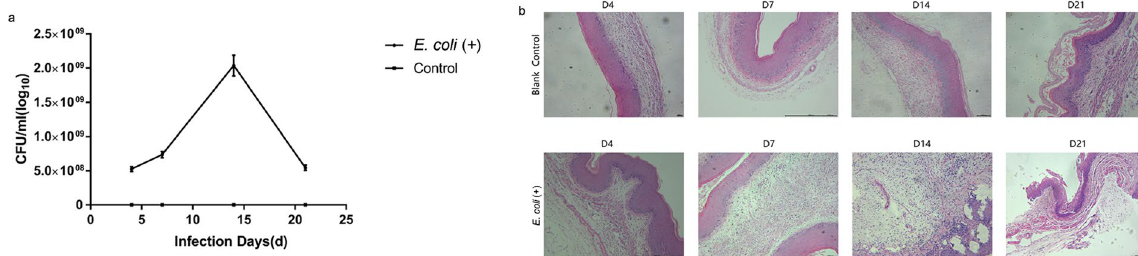
Figure 1. Vaginal infusion of E. coli induced vaginal infection in mice. ( a ) The bacterial burden in vaginal lavage fluids was assessed longitudinally on days 4, 7, 14, and 21; ( b ) Histopathology in reproductive tract tissues from mice after E. coli infection.